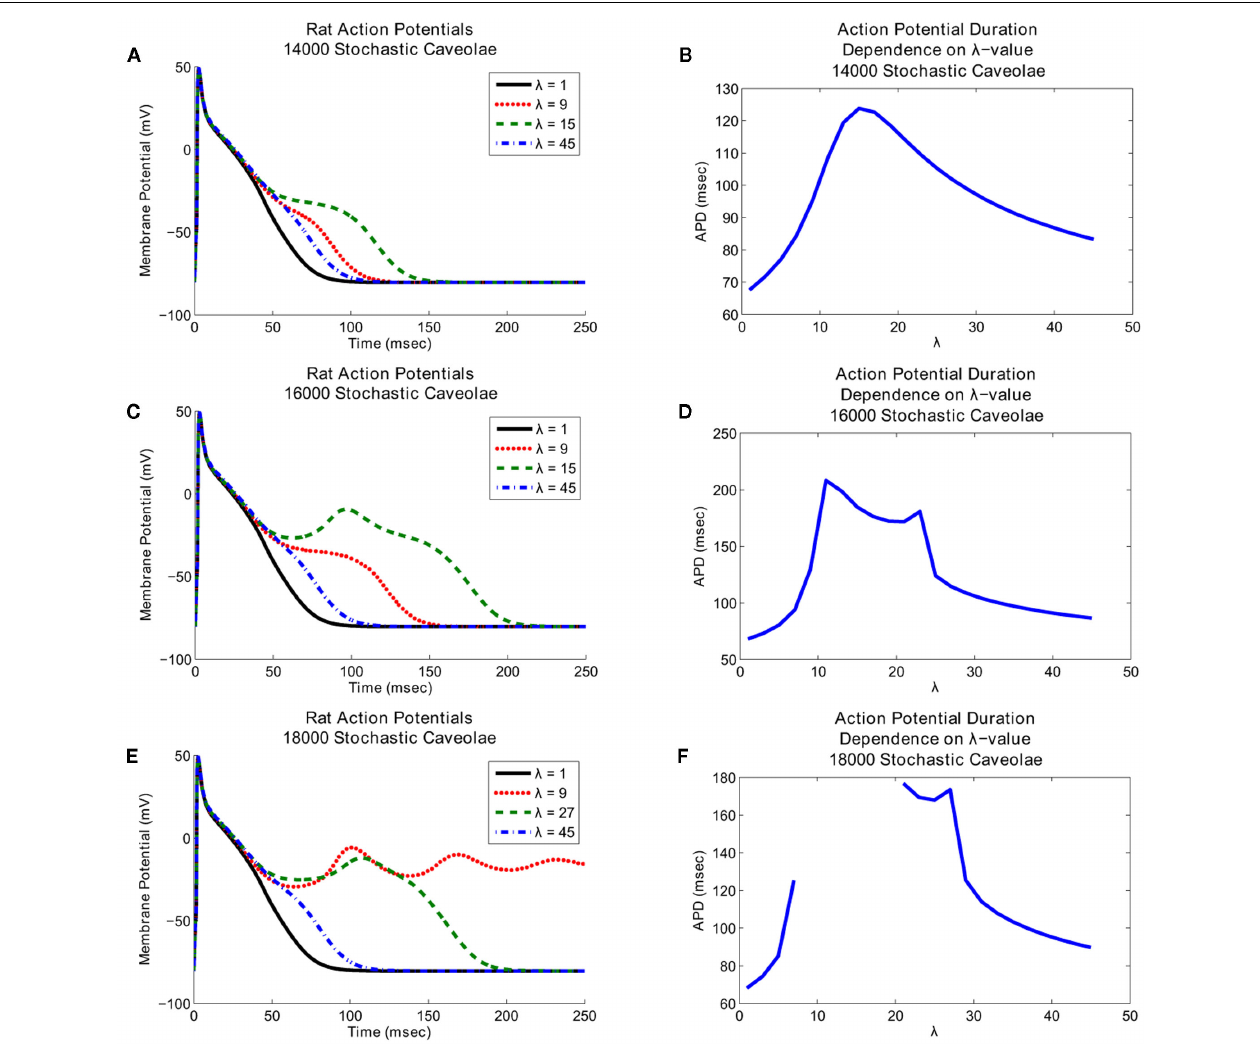
afterdepolarizations. (C) Early afterdepolarizations do occur for small range of λ -values when the number of caveolae is increased to 16000 and (D) even more substantial delays in repolarization result. (E) If the number of caveolae is increased still further to 18000, then early afterdepolarizations occur for certain values of λ . Furthermore, a range of λ -values exists for which the delays in repolarization last long enough for the system to settle into a new equilibrium near a membrane potential of approximately − 5mV. (F) This complete elimination of the repolarization phase shows up as a discontinuity between λ ≈ 7 and λ ≈ 21 in the graph of action potential duration dependence on λ